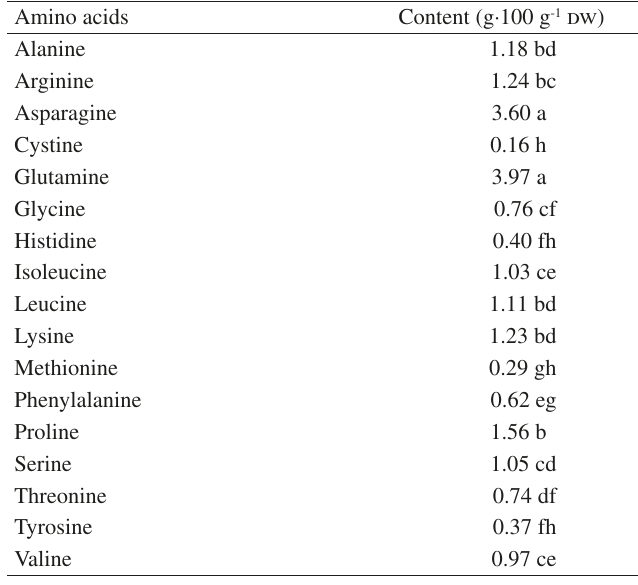
Means followed by different letters are significantly different according to the Duncan test at p≤0.05